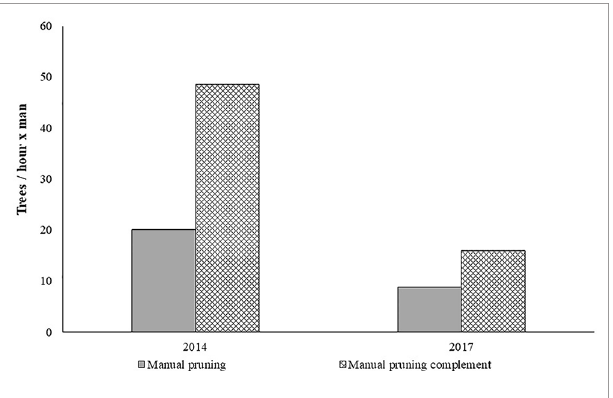
FIGURE 3 | Average work rates of manual pruning.